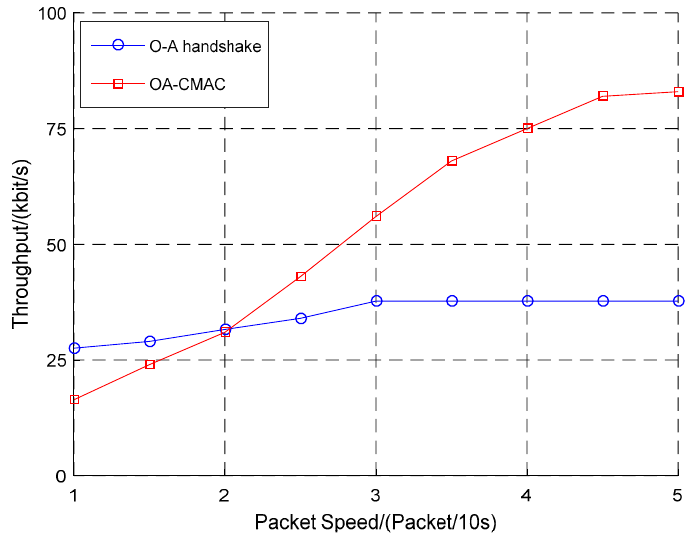
Figure 5. Comparison of three protocol throughputs when the optical handshaking success rate was 20%.